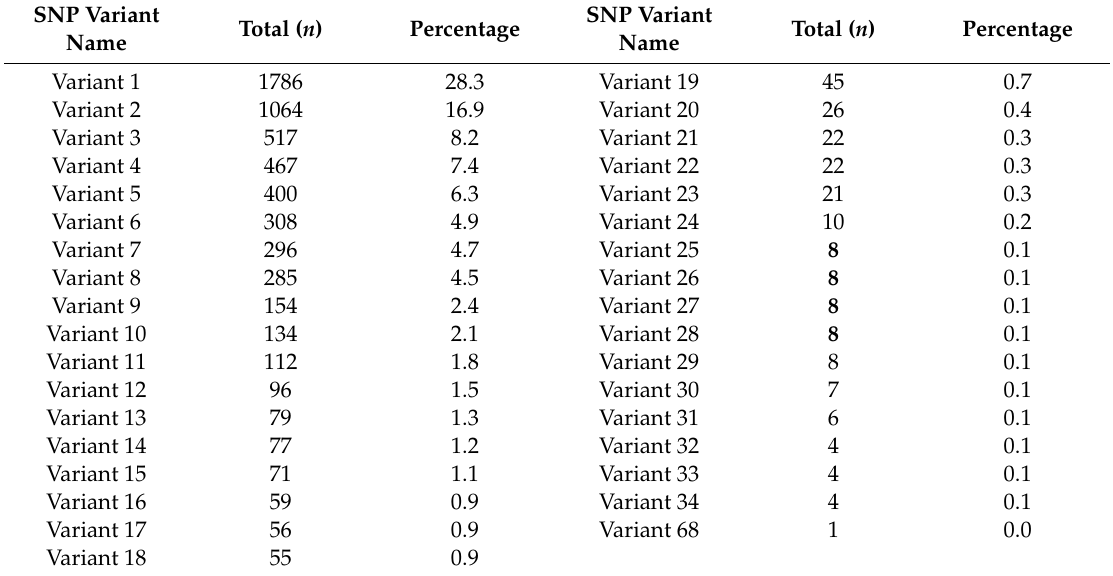
Table 2. The most frequent T1DGC ImmunoChip study edited 27-SNP haplotypes 1 . SNP Variant